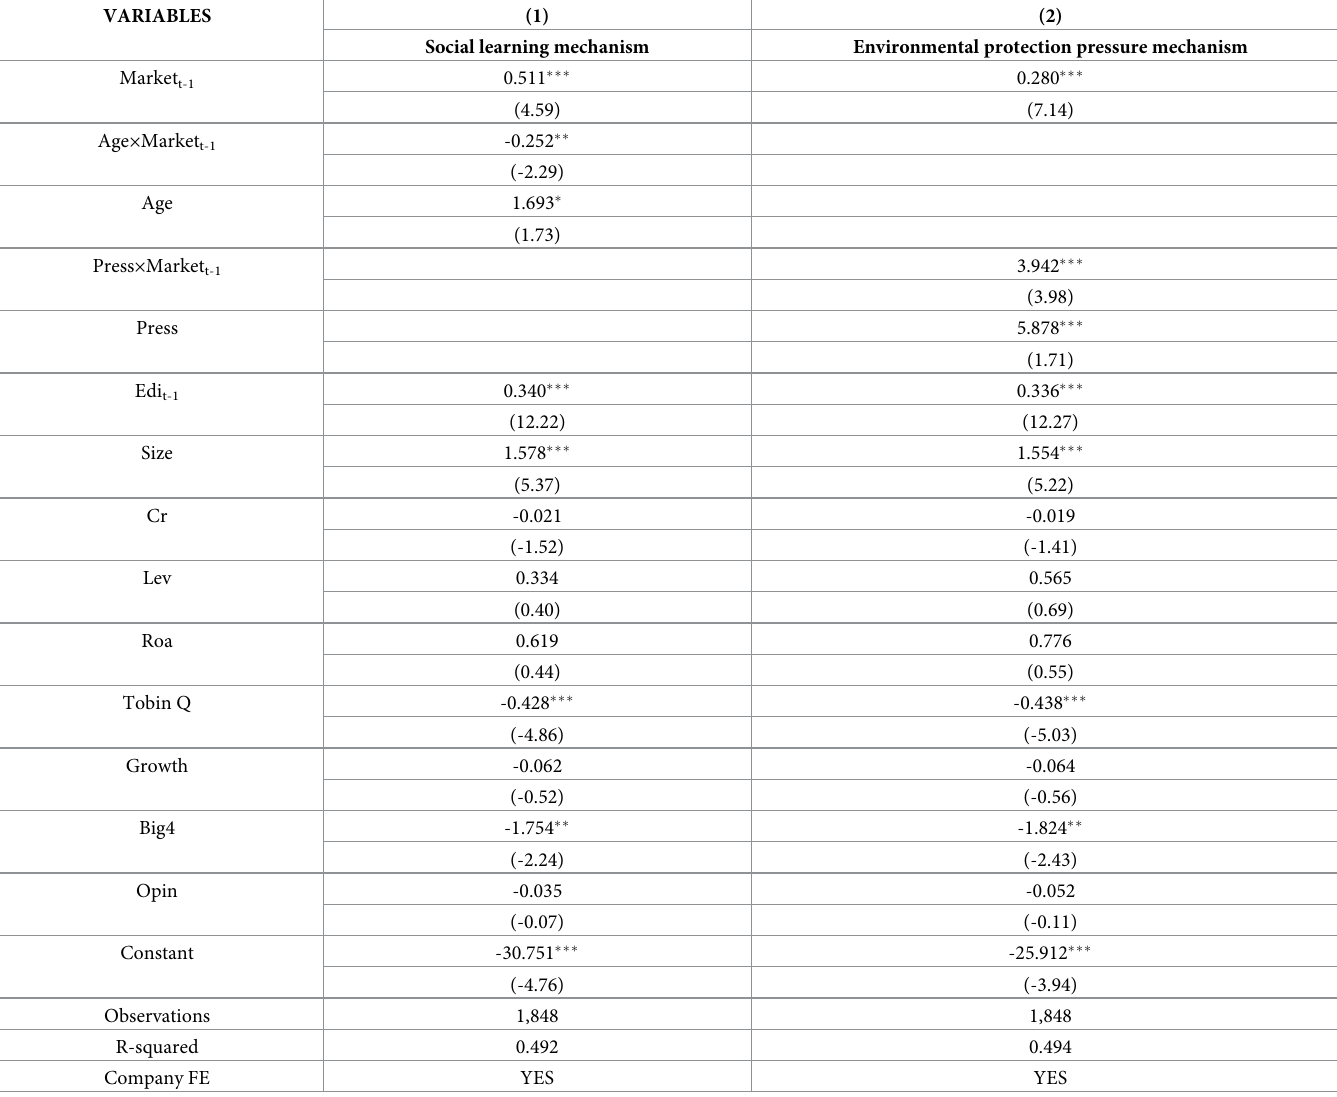
Table 6. Regression test results of intra-industry peer group effect in